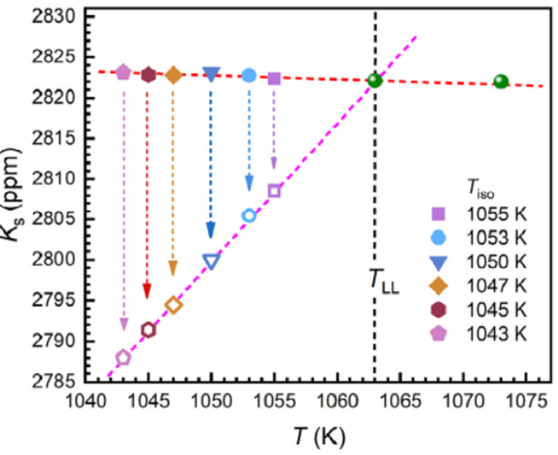
Figure 12. The changes of the Knight shift K s at different undercooled temperatures T iso after quenching the melt from 1173 K. The solid and open symbols represent the initial and equilibrium K s , respectively. Reprinted with permission from ref. [21], Figure 1c, Copyright 2021 Elsevier.